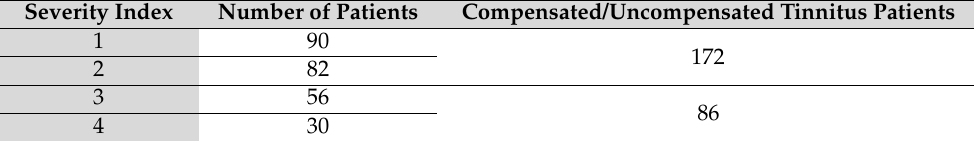
Table 1. Overview of tinnitus severity of the 258 patients.